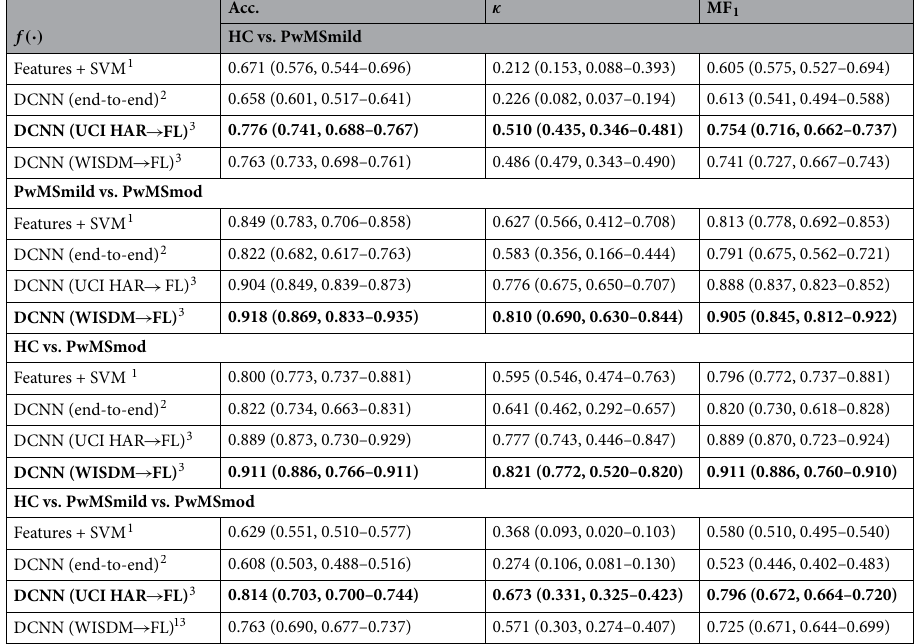
ities ( k ∈ { walking , stairs , sitting , standing , laying } ) were well differentiated (Acc: 0.905 ± 0.018, κ : 0.880 ± 0.023, MF 1 : 0.893 ± 0.025). Much of the confusion between classes occurred between similar “static” activities (such as sit- ting and standing). Distinguishing WISDM-based HAR activities ( k ∈ { walking , stairs , sitting , standing , jogging } ) was less accurate in comparison (Acc: 0.621 ± 0.037, κ : 0.525 ± 0.0047, MF 1 : 0.622 ± 0.038), although much of the relative added confusion in WISDM occurred between similar “dynamic” activities (such as jogging and walking). Despite this, the prediction of static vs. dynamic activities were distinctly separate for both UCI HAR and WISDM.